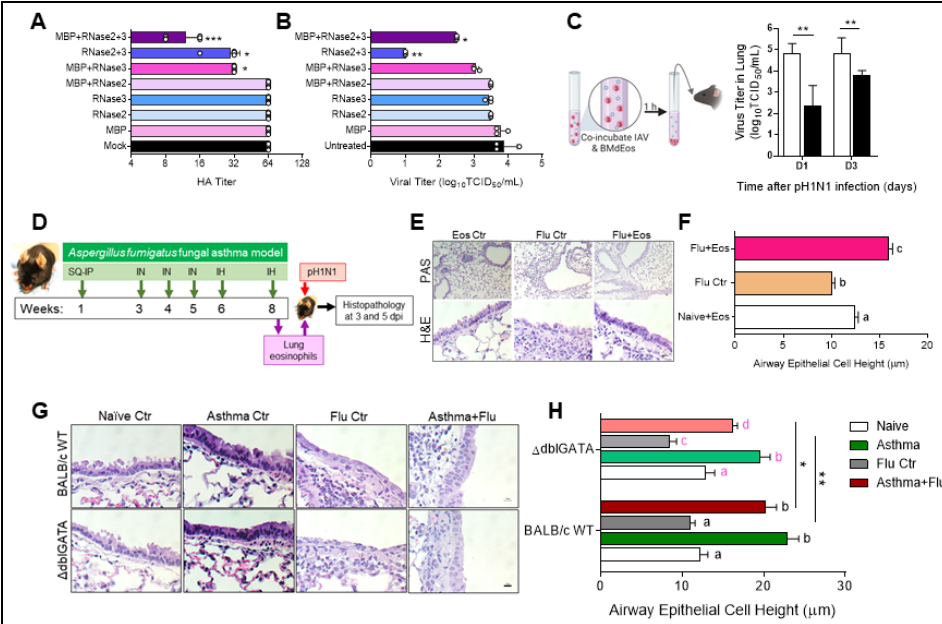
Figure 3. Eosinophils inhibit virus infectivity and protect the airway epithelial barrier from virus- induced cytopathology. Eosinophil-specific granule proteins reduce the ( A ) hemagglutinin (HA) titer and ( B ) virus replication when added in combination. Data are represented as the mean and standard deviation and analyzed with the Kruskal–Wallis multiple comparisons test * p < 0.05, ** p < 0.01 and *** p < 0.001 compared to untreated controls ( C ) Eosinophils and influenza A virus (IAV) incubated at a 1:1 ratio result in reduced virus infectivity in vivo. Data represented as the mean and standard deviation and compared by Mann–Whitney test where ** p < 0.01. Illustration with BioRender. ( D ) Schematic representation of adoptive transfer of eosinophils from allergic mice into the lungs of IAV-infected mice. ( E ) Minimal goblet cell metaplasia seen after periodic acid Schiff’s (PAS) stain in response to eosinophil transfer and hematoxylin and eosin (H&E) staining enable the visualization of epithelial barrier integrity shown at day 3. ( F ) Large airway epithelial height measured in each group shown at day 5. ( G ) H&E stains of large airways in each treatment group were used to measure ( H ) epithelial height in wild-type (WT) and eosinophil deficient (ΔdblGATA) mice. Height measurements of bronchial epithelial cells each in five large airways of each lung section. Data shown at day 5. Scale bars = 10 µm in all photomicrographs. Experiments were repeated independently for reproducibility with 5–6 mice/group each time. Data in F and H are represented as the mean and standard error of the mean and analyzed by two-way ANOVA with Sidak’s multiple comparisons test where letter above bars represent * p < 0.05 when different and no statistical difference when